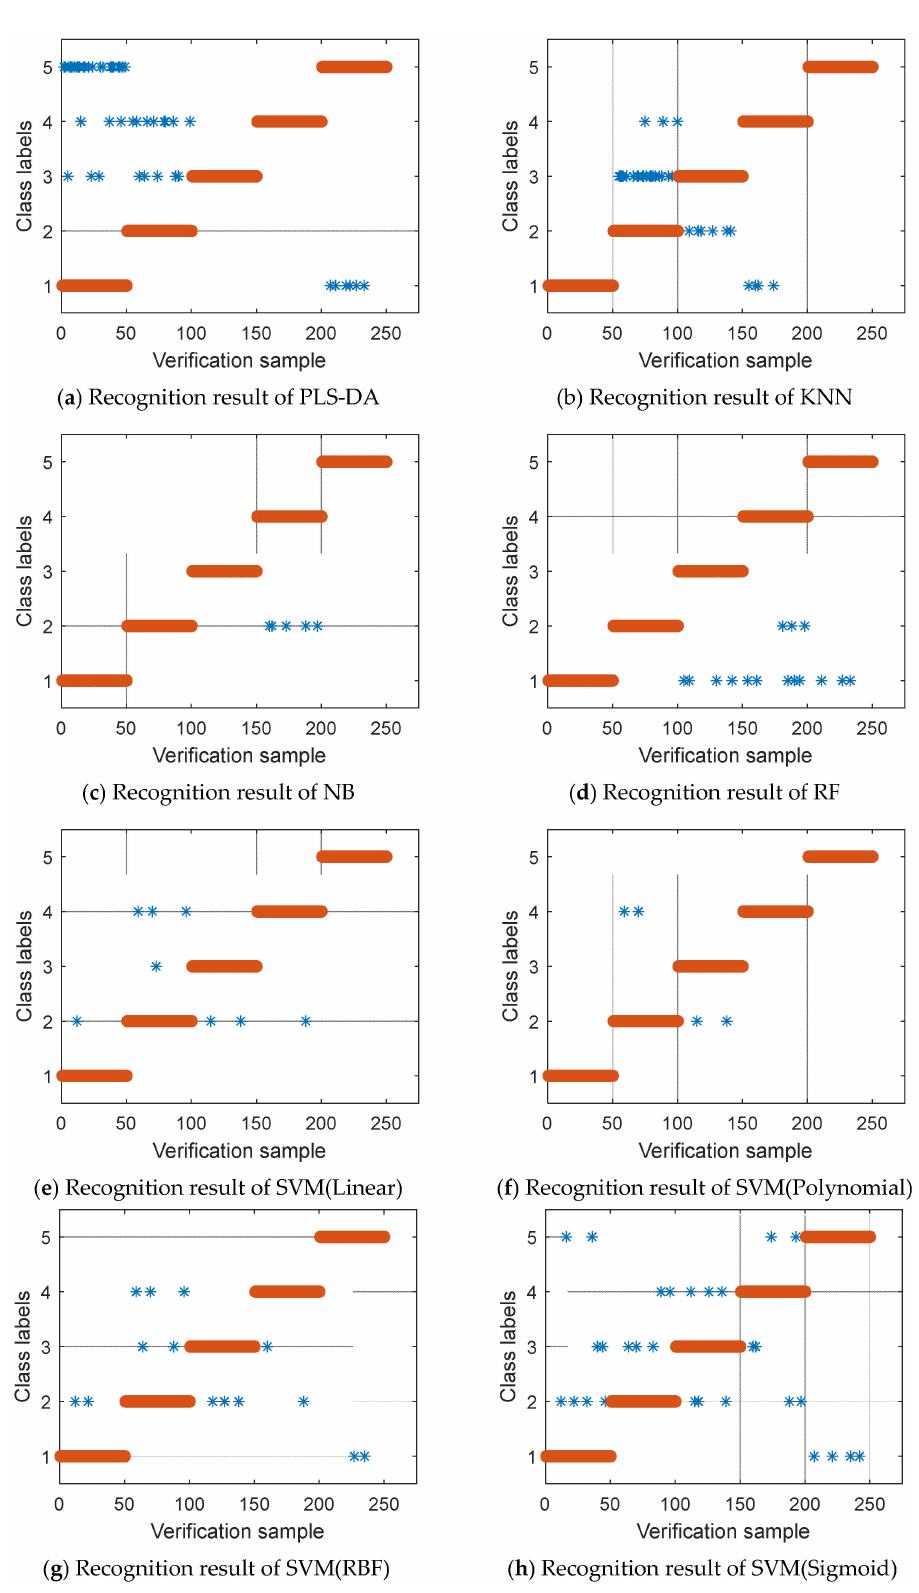
Figure 7. The recognition results of diffident models based on feature wavelengths. The red mark (o) indicates the actual category of corn kernels, the blue mark (*) indicates the predicted category of corn